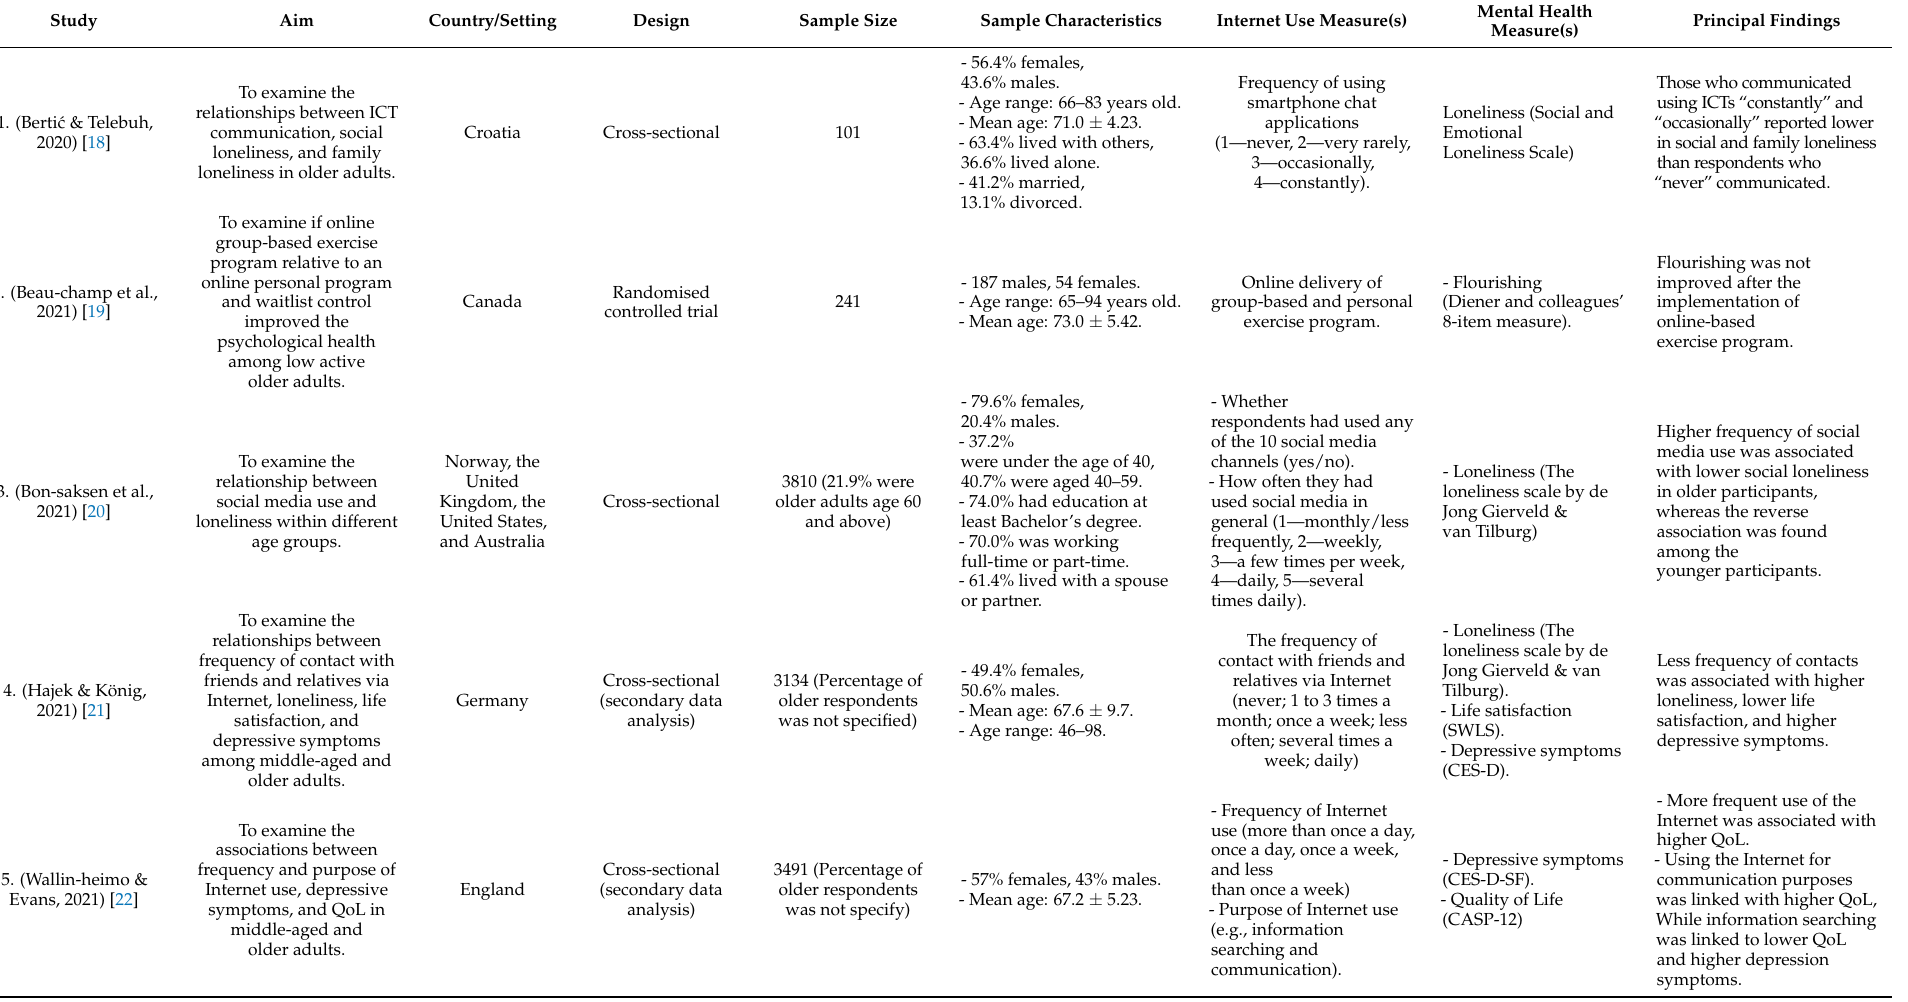
Table 3. Summary of quantitative